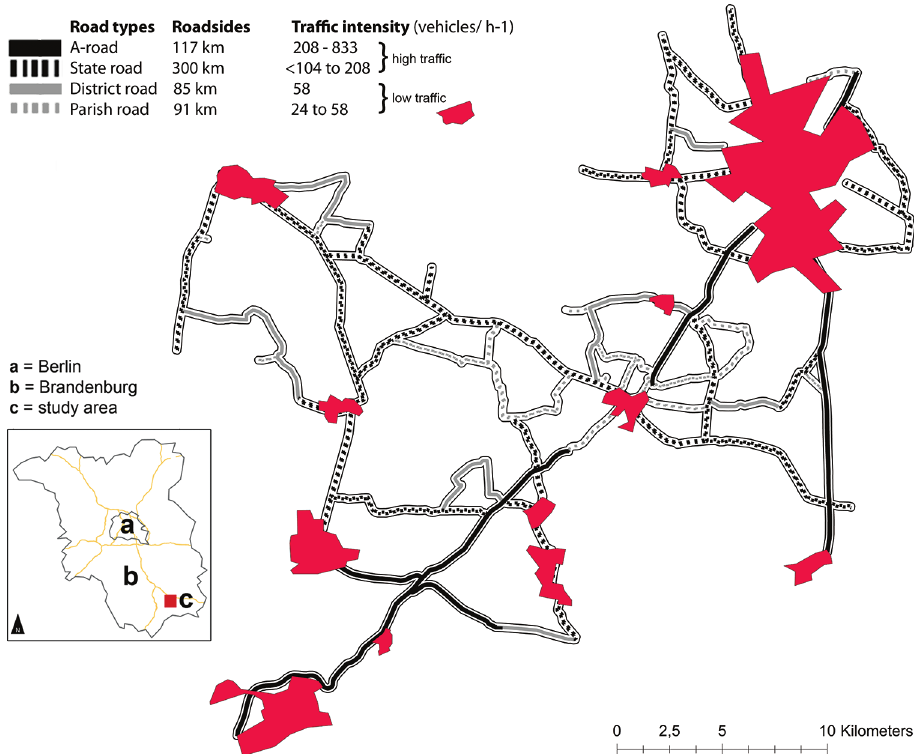
Figure 1. The study area ( c ) is situated in the south east of the Federal State of Brandenburg, Germany ( b ). The mapped road network consists of four road types (black line: a-road , black dotted line: state road ; grey line: district road ; grey dotted line: parish road ). Based on official and additional vehicle counts we pooled a-road and state road to high traffic intensity roads and district road and parish road to low traffic intensity roads . Settlements are displayed in